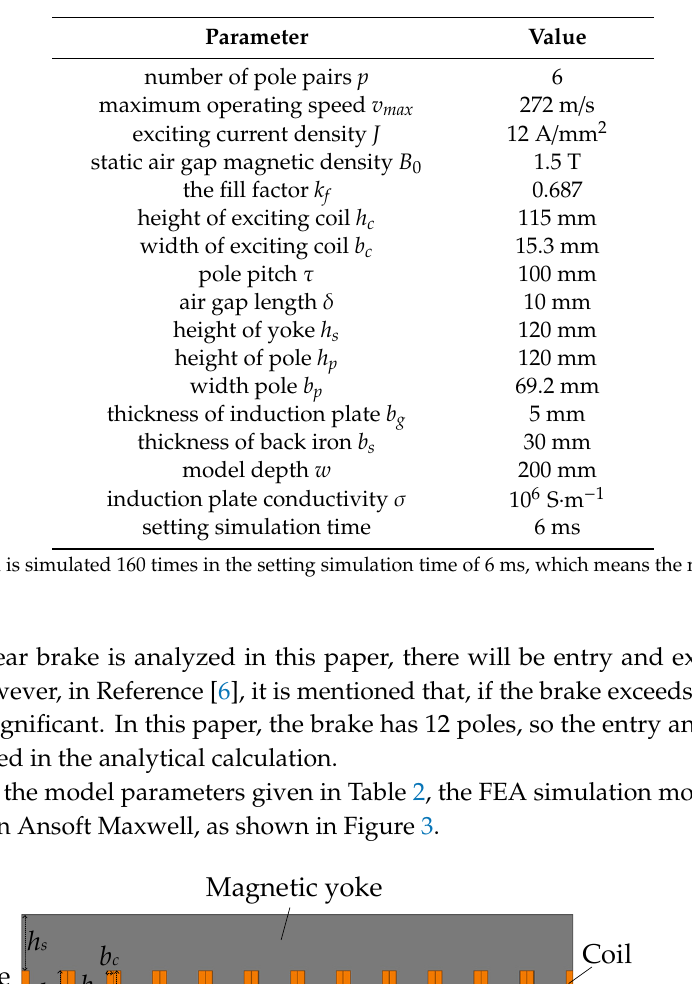
Figure 4. Distribution field diagram of the static magnetic line. Figure 5. Distribution field diagram of static magnetic density. Figure 4 and Figure 5 can verify the accuracy of the model and its simulation. Additionally, it can also be seen from Figure 5 that the air gap magnetic density of the model is slightly less than 1.5